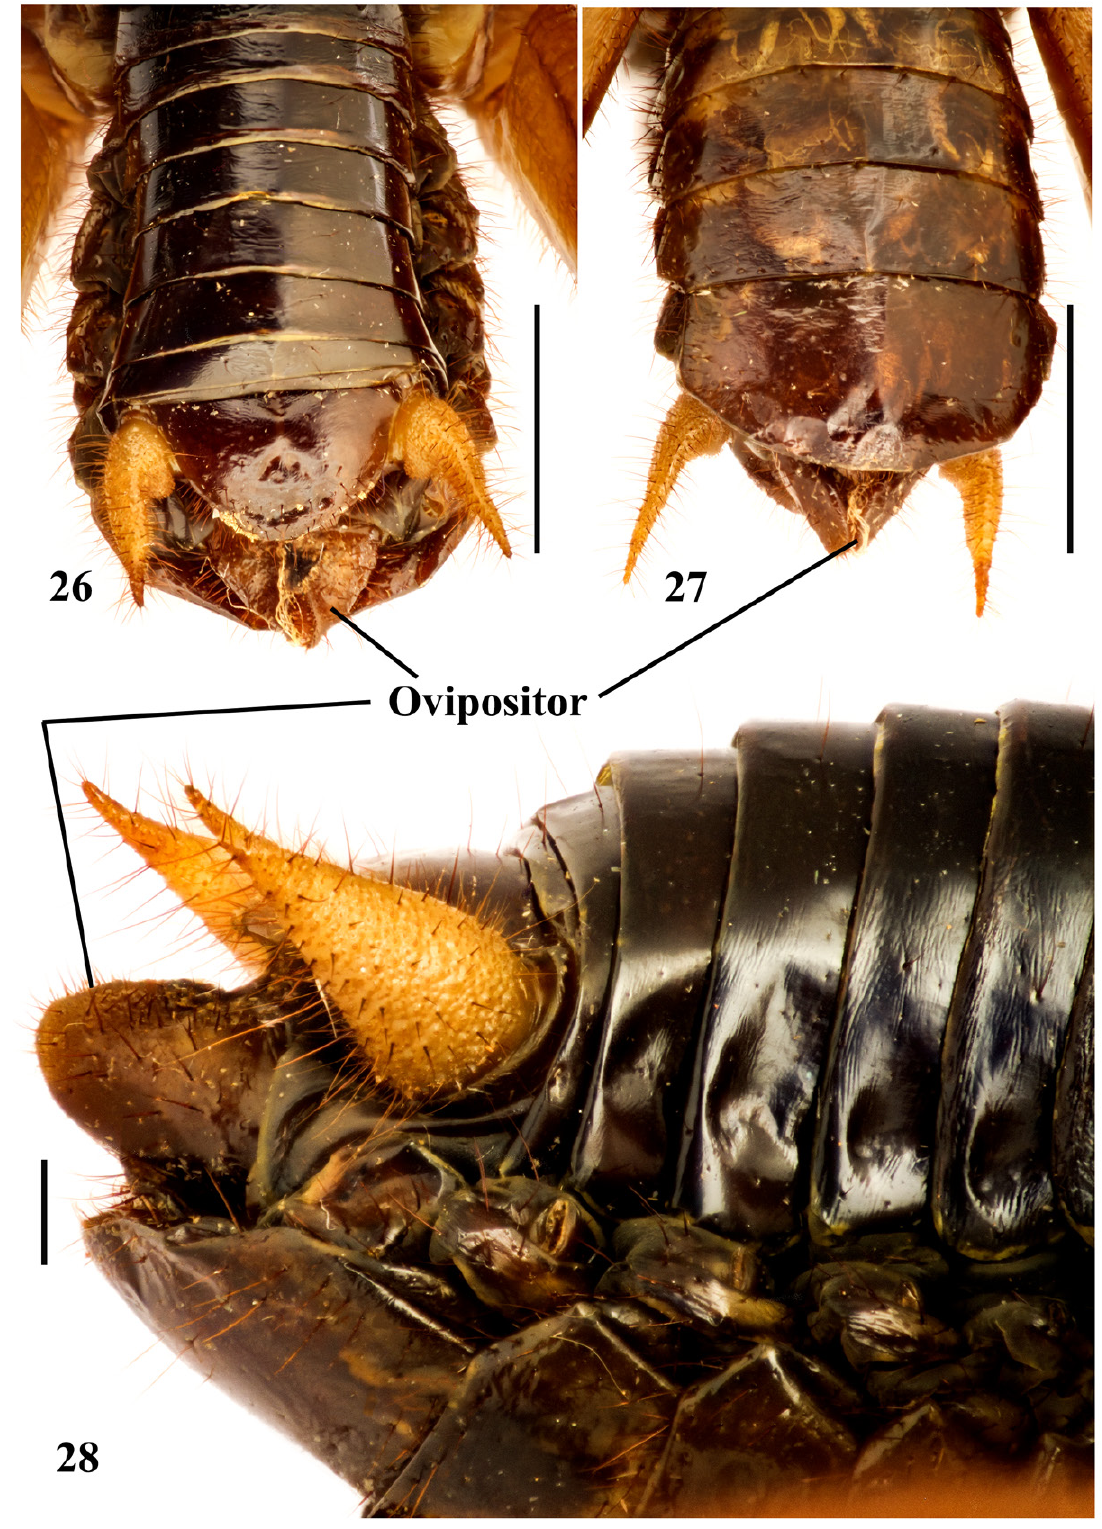
Figs 26–28. Oryctopterus varuna sp. nov. Apex of male abdomen in freshly killed specimen (NBAIR). 26 . Dorsal view. 27 . Ventral view. 28 . Lateral view. Scale bars: 26–27 = 5 mm; 28 = 1